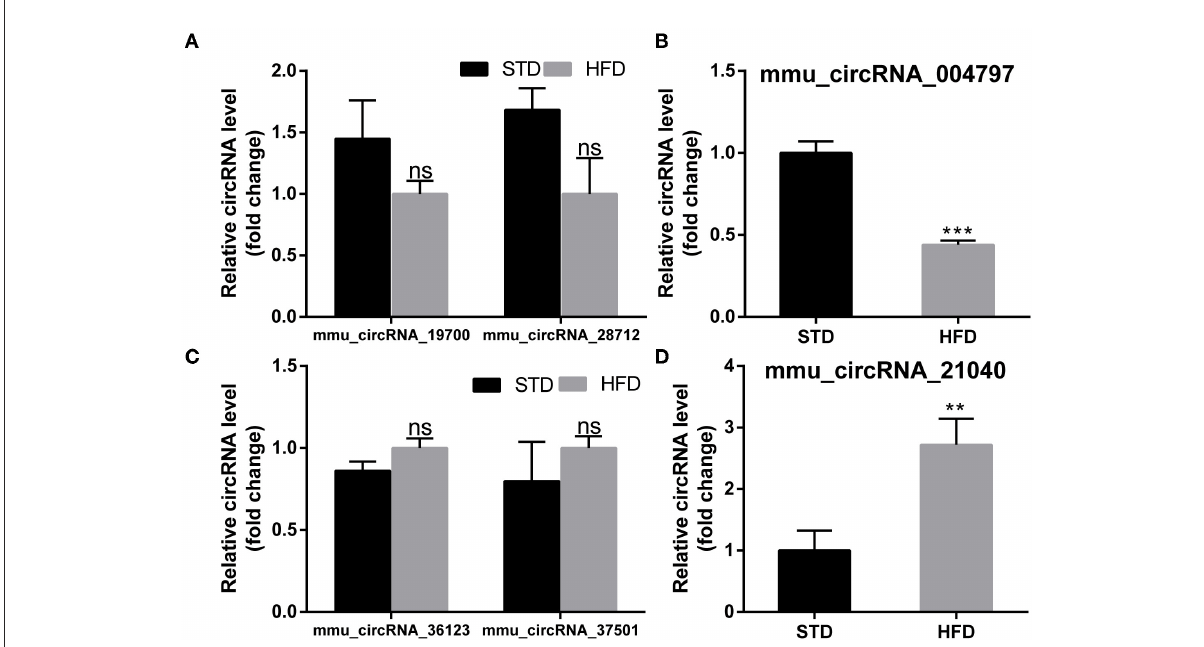
FIGURE6 PCR test to identify the expression levels of circRNA candidates in the hippocampus of mice. (A,B) PCR Quantification results of down-regulated CircRNAs (mmu-circRNA-19700/28712/004797). (C,D) PCR Quantification results of up-regulated circRNAs(mmu-circRNA-36123/37501/ 21040). The experiments were independently repeated three times in each figure ( n = 5,5). ** P < 0.01; *** P < 0.001.